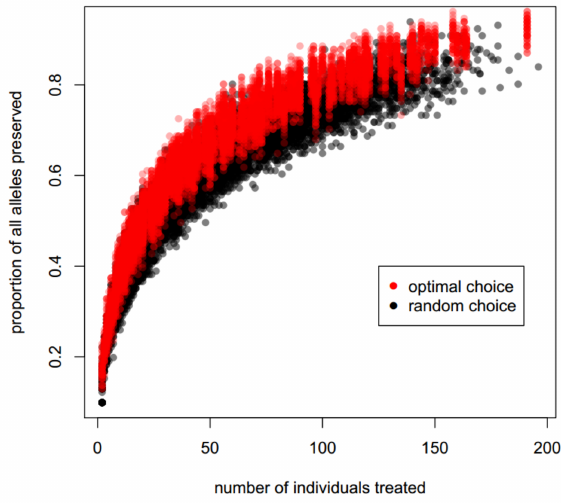
Figure 5. Proportion of genetic variation preserved for a given number of individuals treated depending on whether optimal populations or random populations are